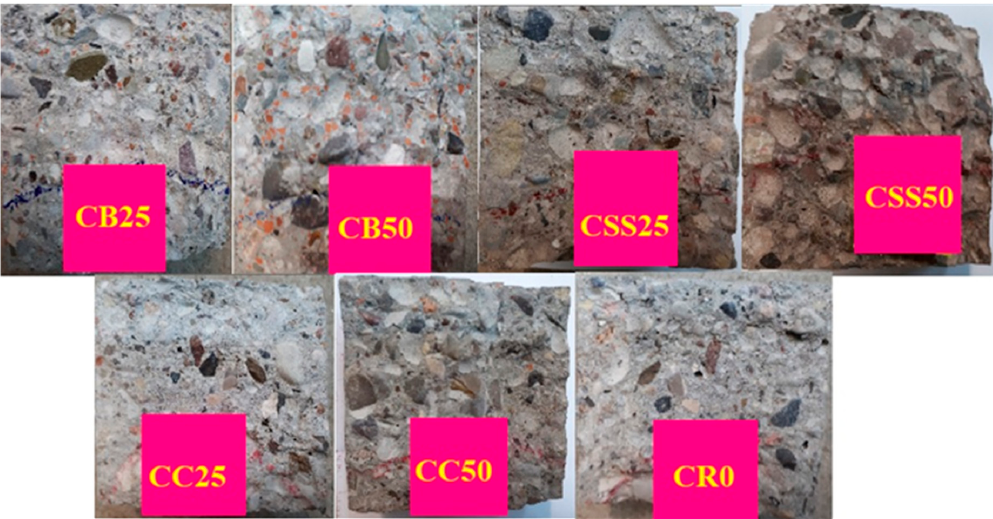
Figure 12. Concrete specimens after testing water penetration depth.